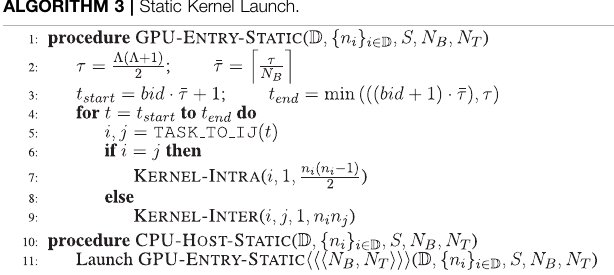
ALGORITHM 3 | Static Kernel